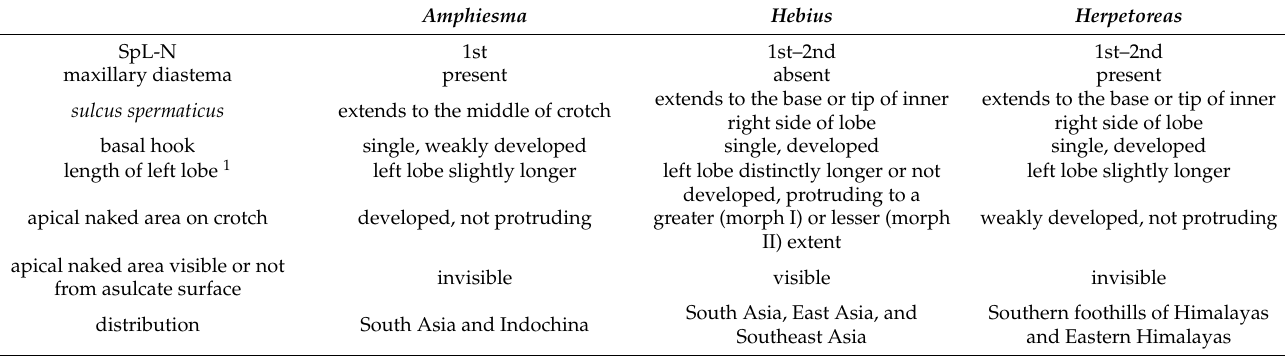
Table 4. Morphological comparisons among different genera of Amphiesma sensu lato